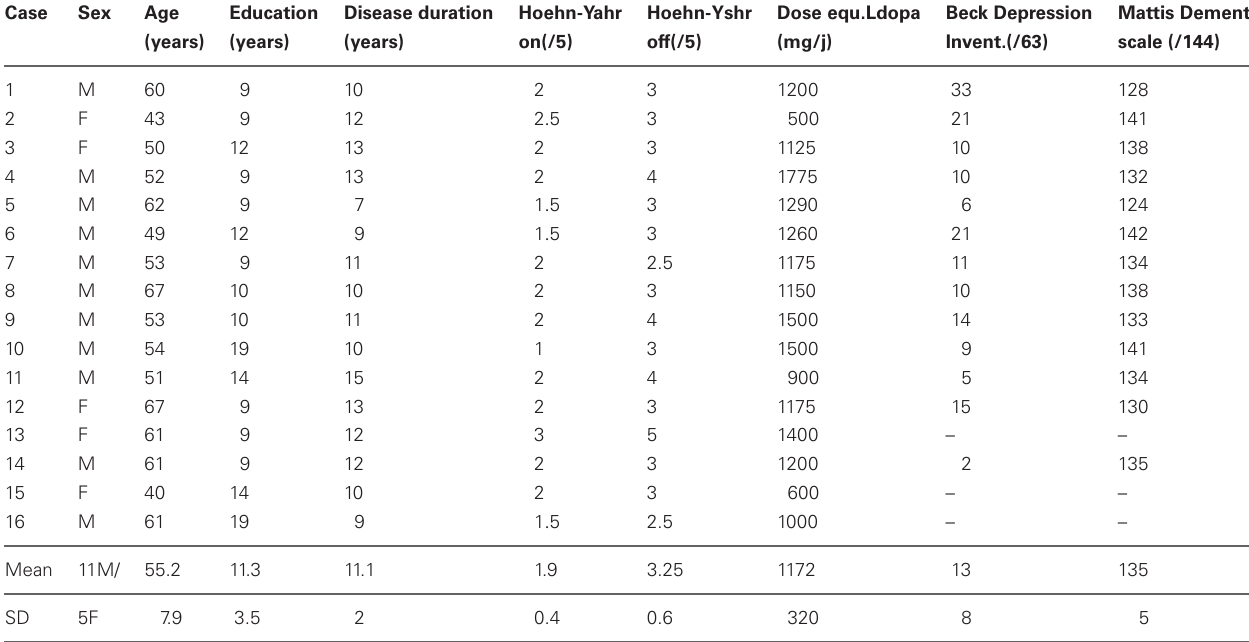
Table 2 | Demographic and clinical details of the patients (means ± SD).